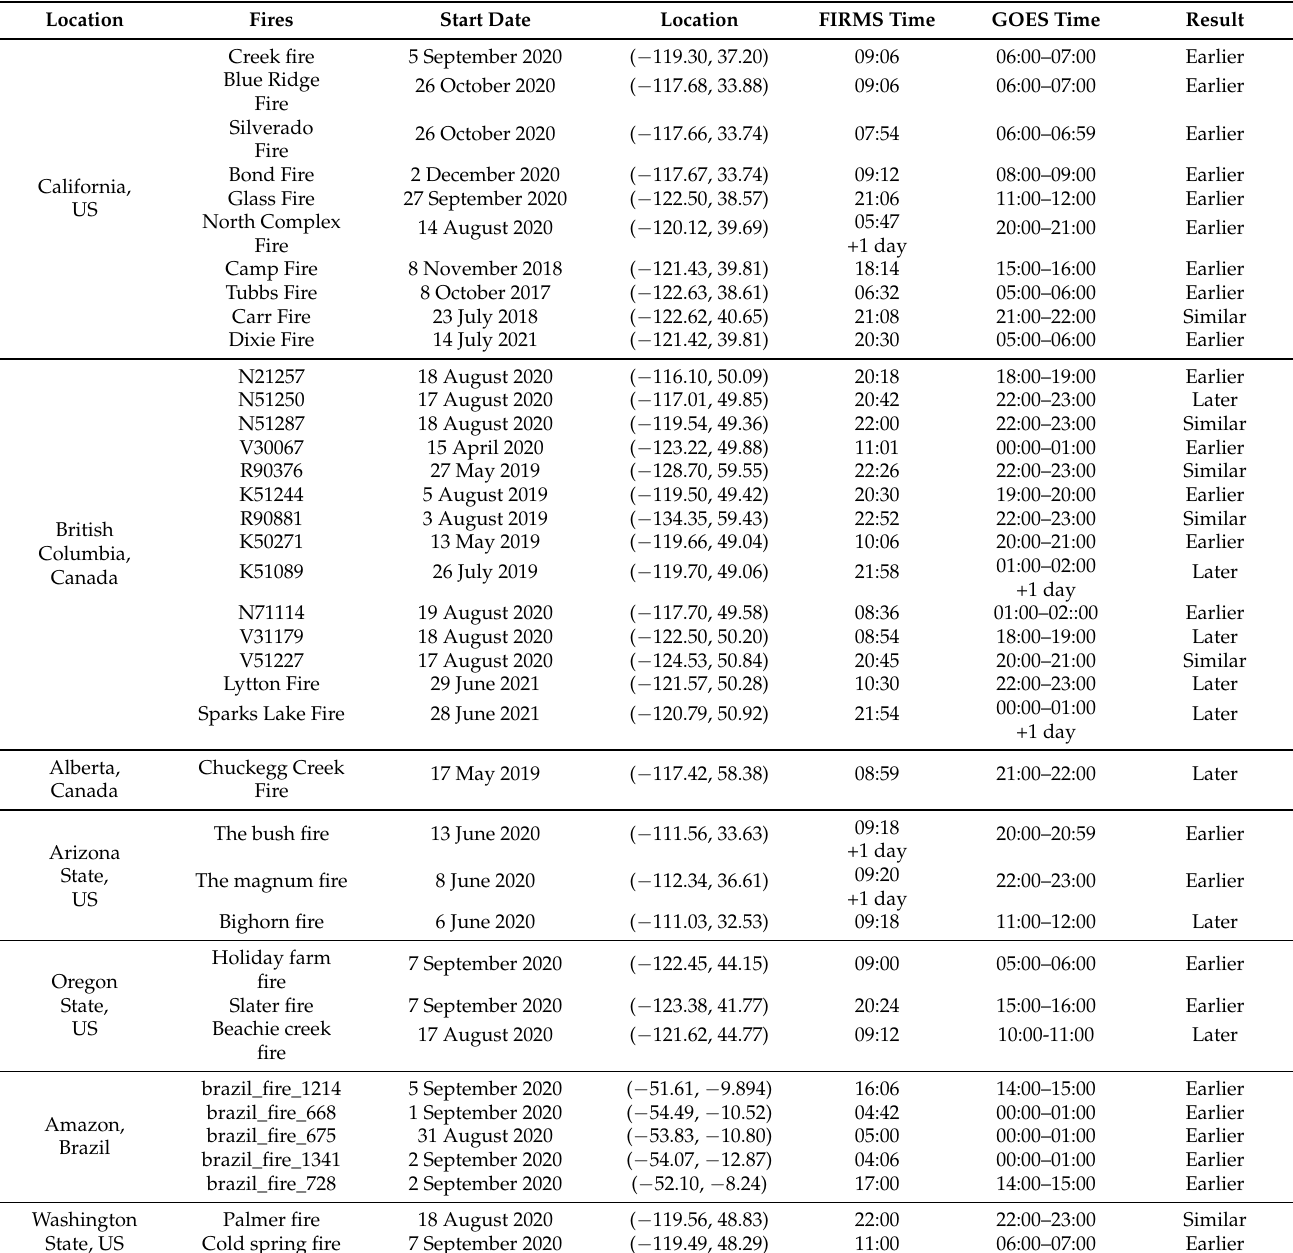
Table 4. Comparison over all study areas for FIRMS detection time and Deep GRU network detection time, ‘+1’ means the detection of the active fire happens on the next day of the start date. The name of the wildfire are either named after fire names from The Department of Forestry and Fire Protection of California, fire numbers from British Columbia Wildfire Service, fire numbers from 2020 Major Amazon Fires Tracker, developed by InfoAmazonia, and the location of the wildfire where it